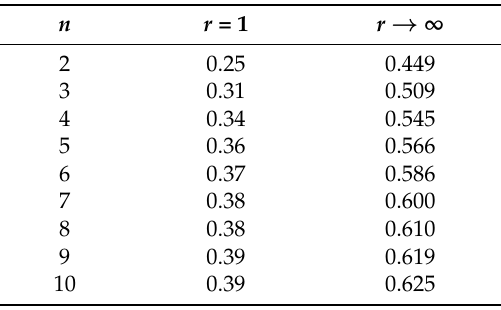
Table 1. Expected levels of risk taking in the Nash